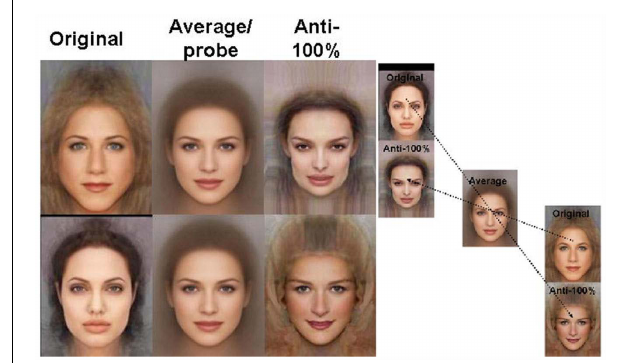
FIGURE 1 | Left: Examples of composite celebrity images (Jennifer Aniston andAngelina Jolie), anti-100% faces used as adapting stimuli, and the average female celebrity composite used as a probe face. Antifaces are created by transforming the original face through the average face in both shape and color. Right: Schematic example of face space showing antifaces “on the other side of the mean.” Arrows designate direction of transform.